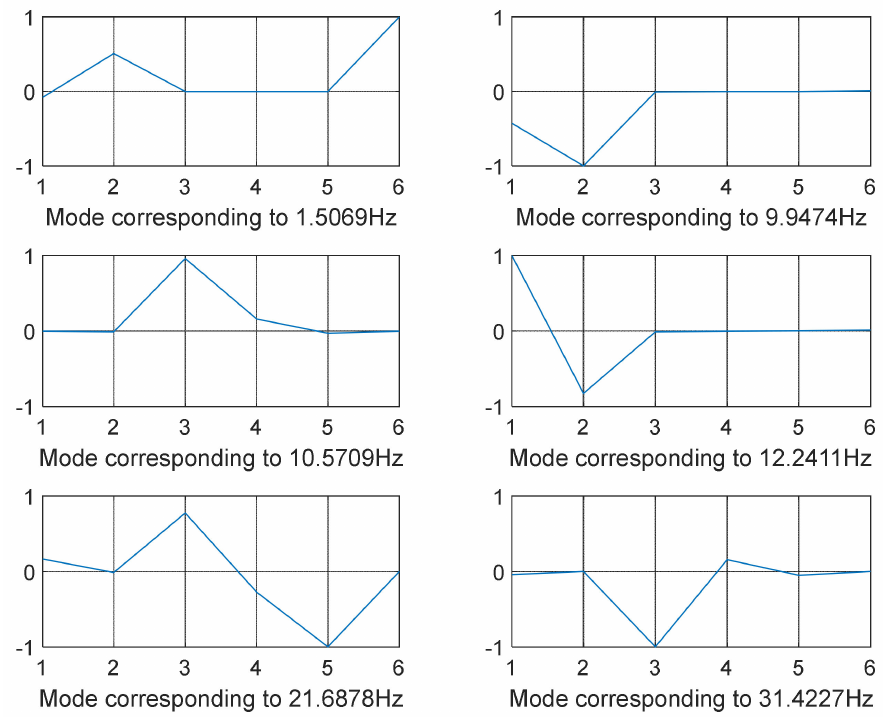
Figure 11. GA-optimized mode shapes 1–6 (12-DOF model—combined